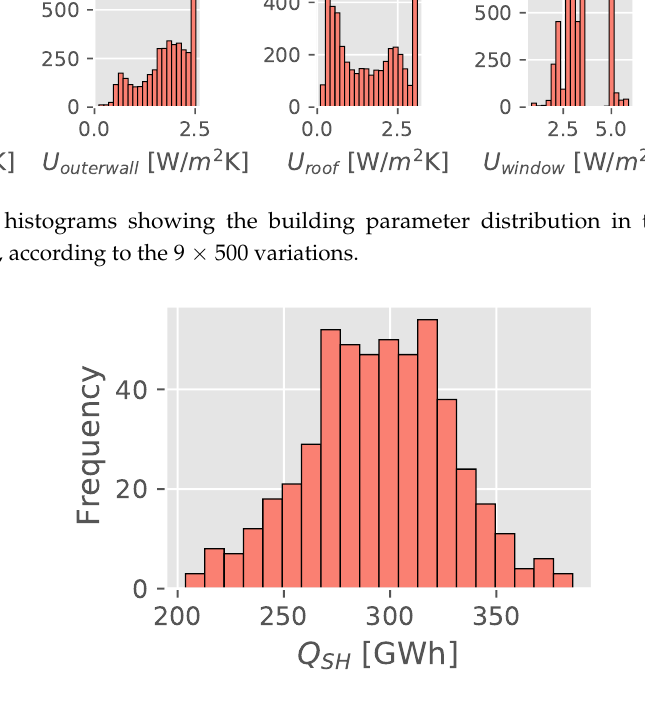
Figure 4. A histogram showing the distribution of the annual GenkNET heat demand, according to the 500